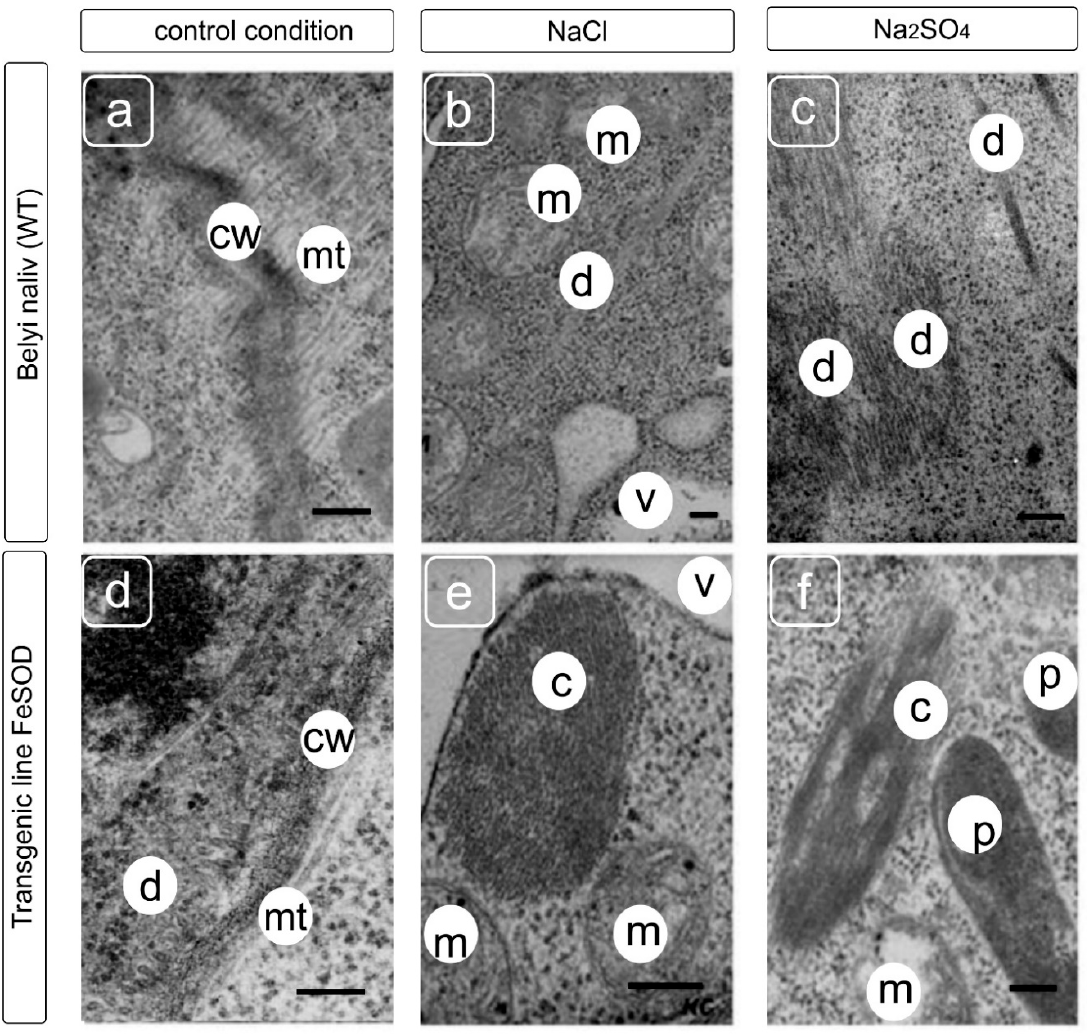
Figure 5. Ultrastructure of root cell from WT ( a – c ) and Fe-SOD-transgenic tomato ( d – f ) plants grown without and supplemented with NaCl and Na 2 SO 4 . Symbols: mt—microtubules, cw—cell wall, m–mitochondrion, v—vacuole, p—plastid, c—atypical cytoskeleton structure. Scale bars—250 nM.